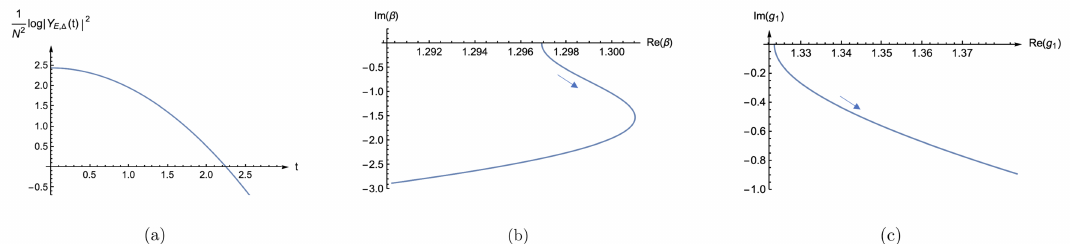
Figure 16 . The numerical solutions to (A.4) with E = 0 . 6 N 2 , ∆ 2 = 0 . 5 N 2 . In (b), (c) we used the arrows to show which directions the curves are running with time. The value of g 2 is nonzero in the solution, but it is tiny (of order O (10 − 3 ) ), so we did not show it.